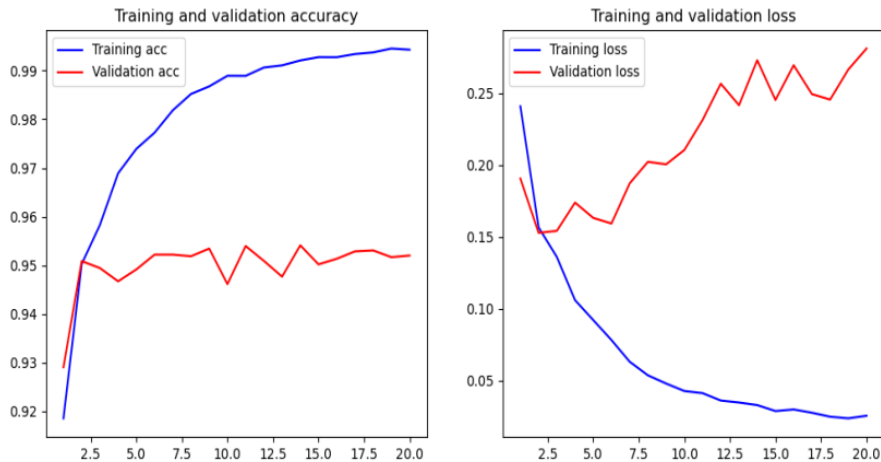
Figure 19. Evaluation of the proposed model on